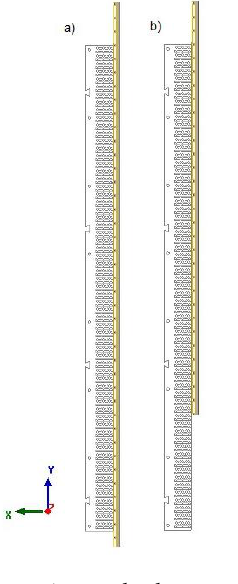
Figure 1. Overall illustration of the linear generator the paper focus on. Table 1. The main dimensions of the generator.